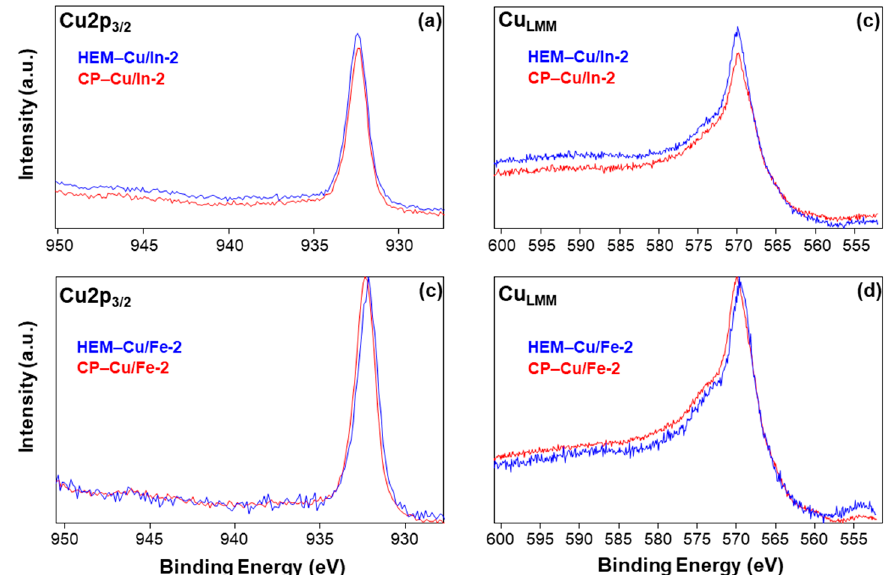
Figure 1. X-ray Photoelectron spectra for Cu 2p 3/2 and Cu L 3 M 4,5 M 4,5 (Cu LMM)Auger transition in ( a , b ) Cu/In and in ( c , d ) Cu/Fe pairs.